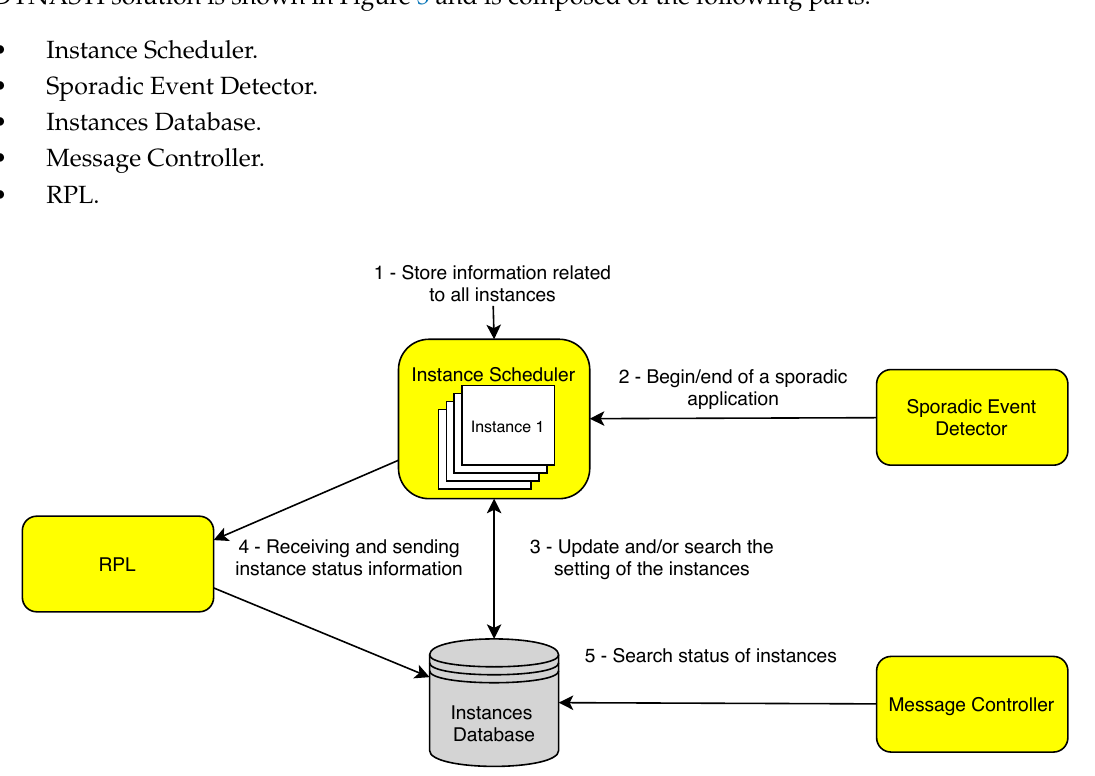
Figure 3. Flowchart of the mechanisms of the DYNASTI solution in the sensor